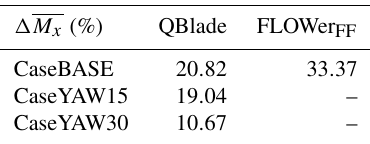
Table 14. Relative differences among the different simulation re- sults of the averaged edgewise bending moment with respect to the FLOWer solution including wind tunnel walls.